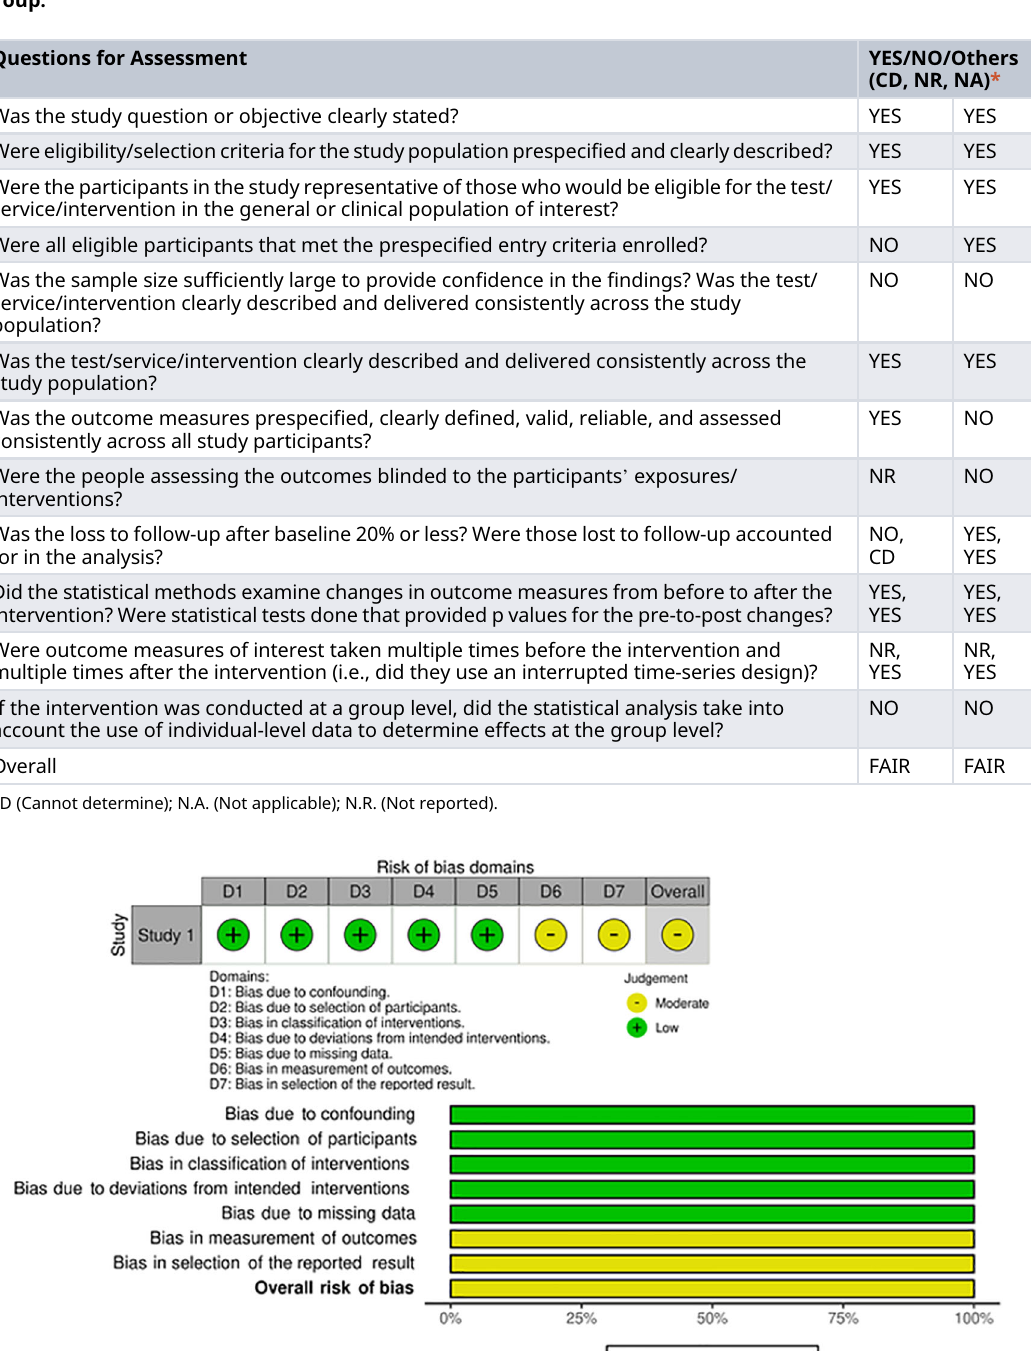
Table 2. Risk of bias assessment of study 1 by Sanmamed et al . 31 and study 3 by Ameri et al . 34 carried out according to National Institute of Health quality assessment tools for before-after study with no control group.